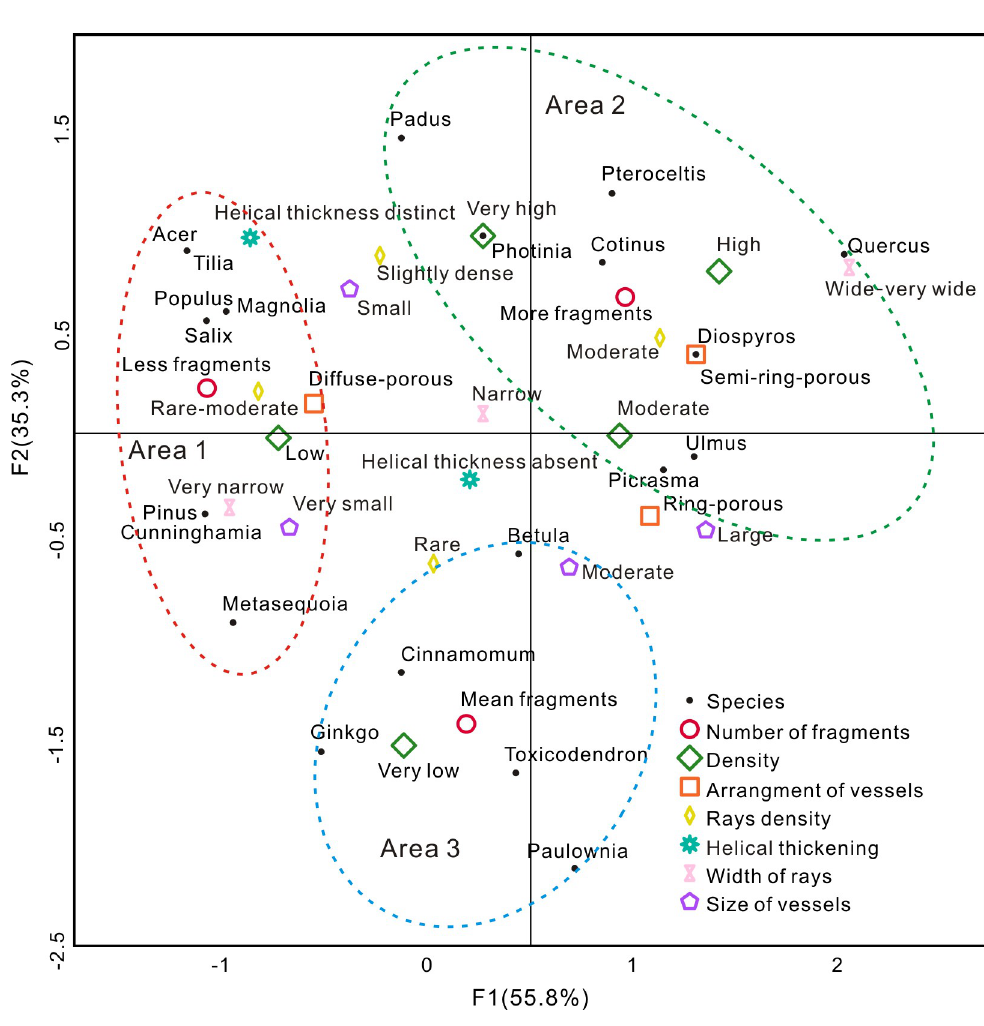
Fig 7. Multiple correspondence analysis